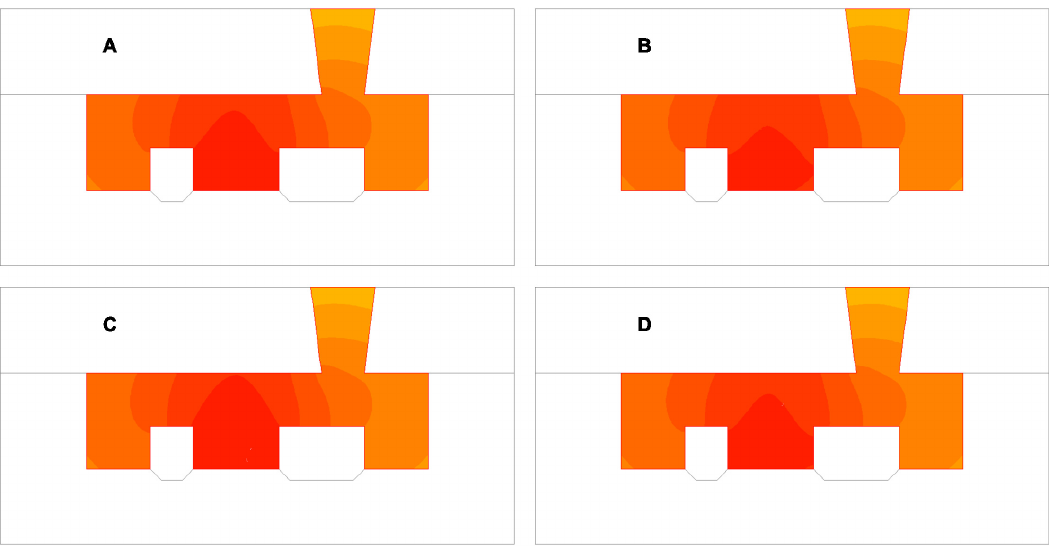
Figure 7. Temperature field obtained for selected point in casting domain after 136.5 s of solidification process (red color denotes the highest temperature and yellow color denotes the lowest temperature in the cast). Four combination of the time integration schemes ( A ) I − I m , ( B ) E − E m , ( C ) E − I m , ( D ) I − E m for multiplication factor m = 1.